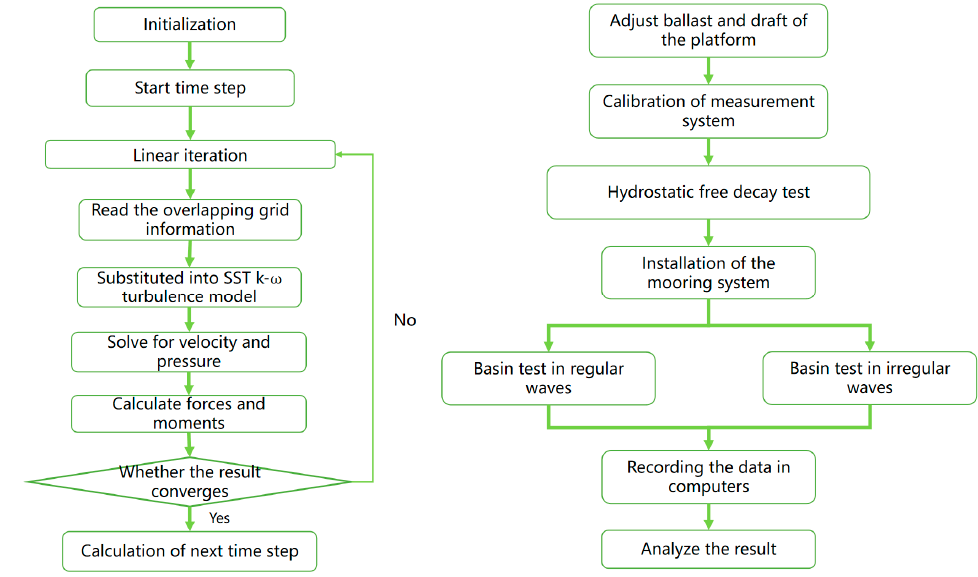
Figure 6. Top-view diagram of the test model after installation.